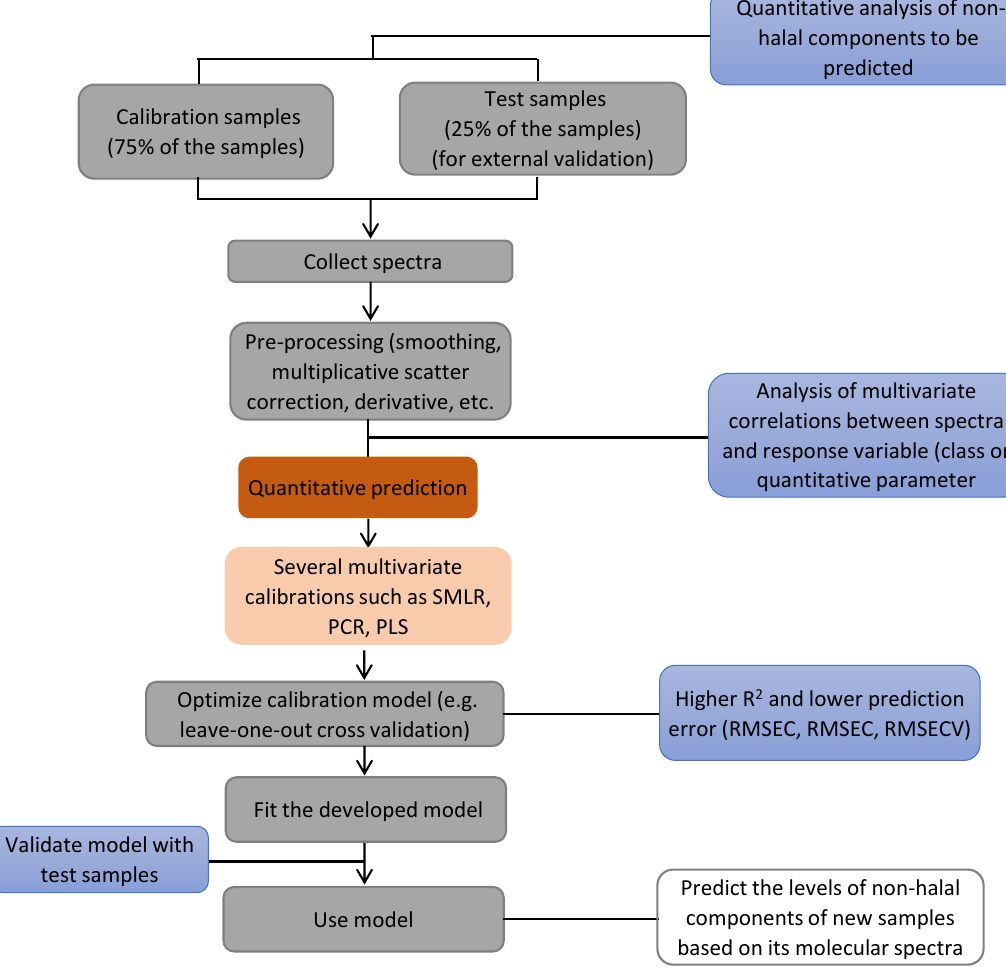
Figure 2. Scheme of quantitative analysis of non-halal components in food and pharmaceutical products assisted by multivariate calibration [42].